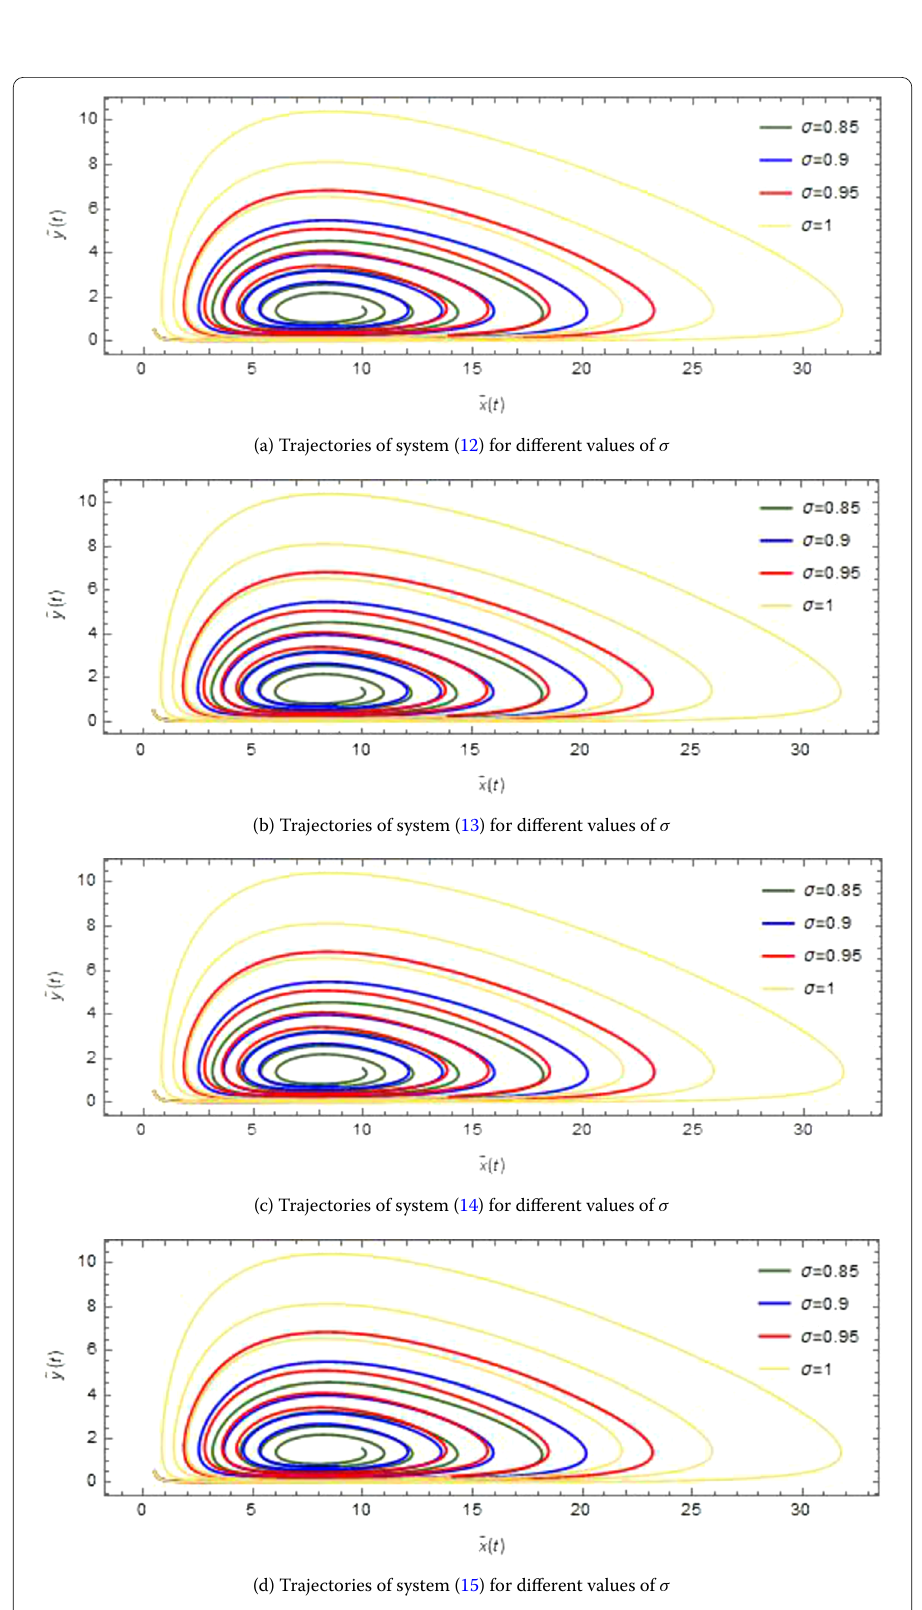
Figure 8 Limit cycles of the prey–predator model for α = 1, q 1 = 0.2, q 2 = 0.7, t ∈ [0,20] and E =